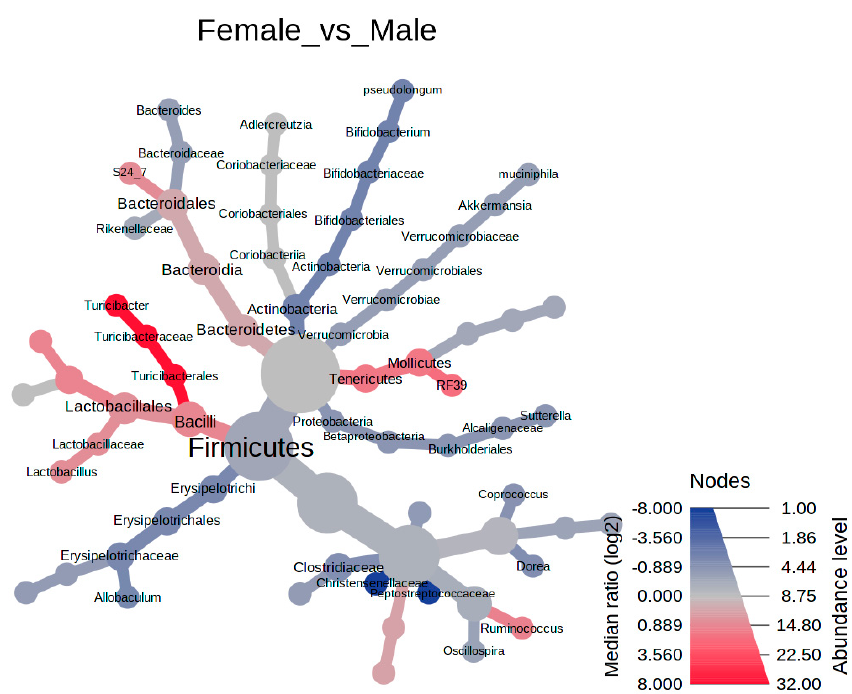
Figure 5. The Heat Tree analysis of taxonomic changes in the female versus male cohorts. The color corresponds to the log2 ratio of median proportions of taxa observed in each cohort across only bean-containing diet groups. Only significant differences are colored according to the Wilcoxon rank-sum testing. Nomenclature used herein is according to the Greengenes database. To determine which bacteria are the most influential in driving the differences across the diets in each sex cohort, LEfSe was performed. LEfSe indicated that 25 microbiota were statistically differential biomarkers of diet groups in the female cohort (Figure 6a,b). Ac- cording to the pairwise LEfSe analyses, Rikenellaceae (I), Bacteroides (II) , and Clostrid- ium (I) significantly increased compared with the control in all bean-based diets, whereas higher counts of Muribaculaceae, Sutterella , and RF39 were observed starting from the 35% dose of bean. These 6 bacterial groups comprise a bean-enhanced eco-group in the female mice (Figure 6a). Interestingly, Coprococcus was statistically enhanced in the 17.5% bean group versus bean-free control, but not in the higher bean dose groups. Similarly, Anaeroplasma was significantly different from the control only in the 35% bean group. In the male cohort, there were 28 differential bacterial biomarkers across the diet groups (Figure 6c,d). Among them, Rikenellaceae (I) and Clostridium (I) steadily increased in all bean-based diets compared with the control group; Bacteroides (II) and Coprococcus were enhanced starting from 35% bean dosage, whereas unclassified Clostridiales (I) and RF39 were significantly enhanced compared to the bean-free control only in the 70% bean group. These taxa form a bean-enhanced eco-group in the male mice (Figure 6c). Interest- ingly, in the 35% bean diet group, Turicibacter was also statistically different from the con- trol and 17.5% bean groups, but not in the higher 70% dose group. The bean-suppressed eco-group in the male samples was comprised of Allobaculum, B. pseudolongum , Parabacteroides , Clostridiaceae (II), Lactobacillus (I) , Dorea , R. gnavus , Ru- minococcus , AF12 , C. cocleatum , Lactococcus , Ruminococceae (II), and Dehalobacterium ,